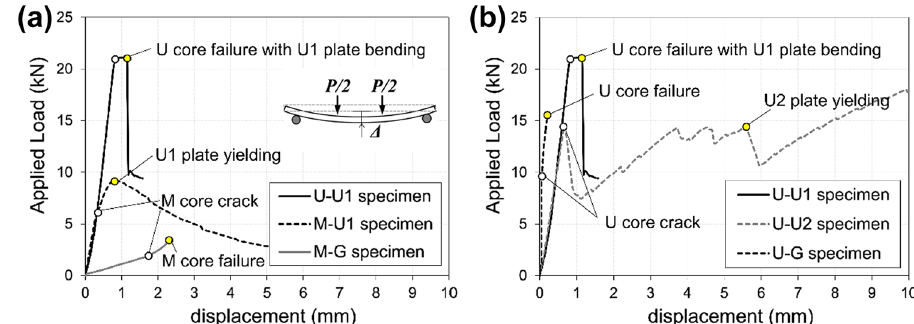
Fig. 11 Force–displacement relationship of flexural tests for composite sandwich panels; a comparison of test results for the specimens with UHPFRC plate and b comparison of test results for the specimens with HPEPC core.